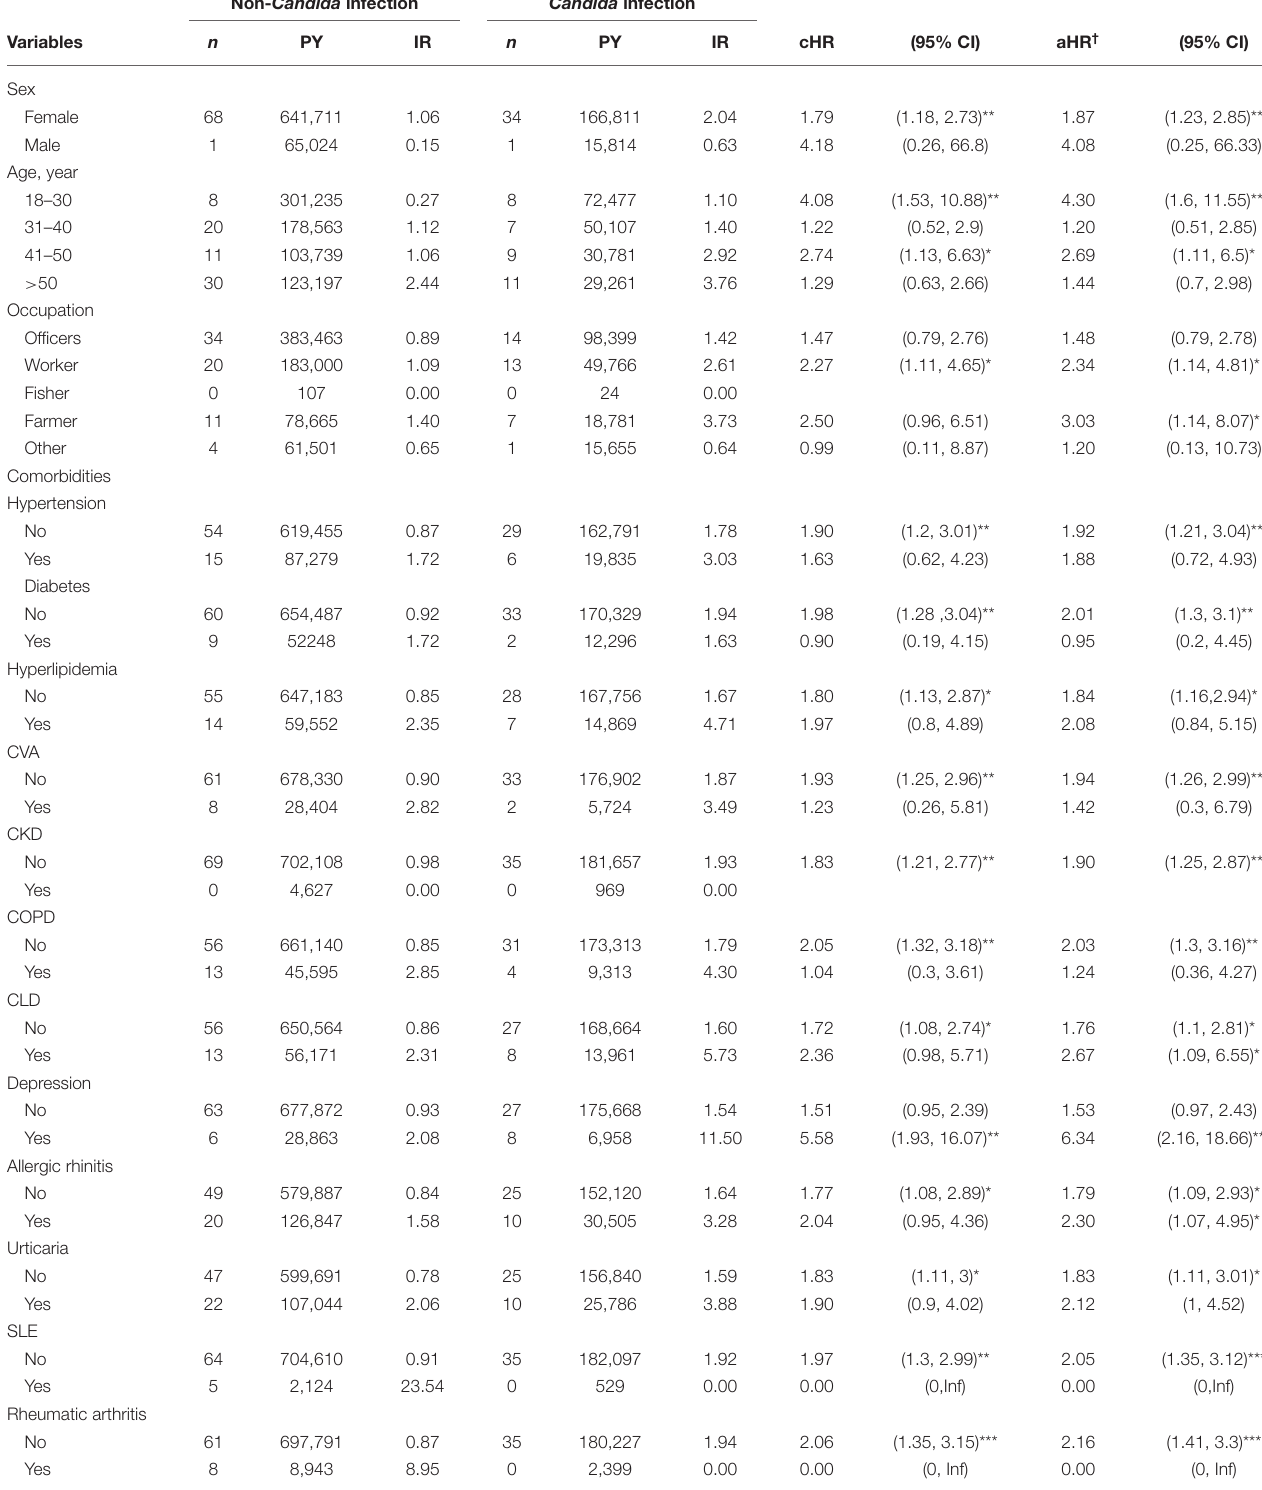
TABLE 3 | The risk of Sjögren’s syndrome in different stratification. Non- Candida infection Candida